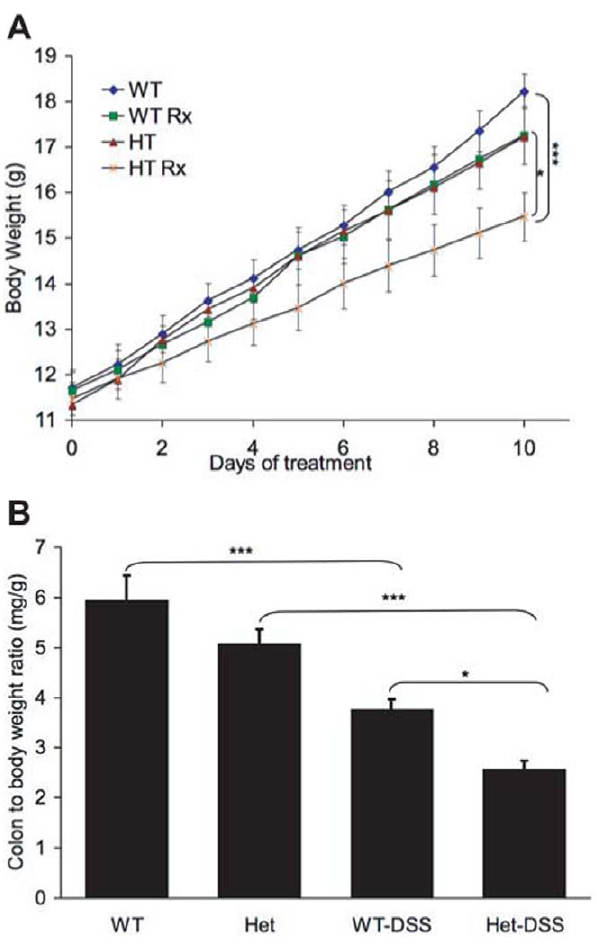
Figure 1. Increased response to DSS treatment in the presence of only one allele of TC-PTP. A . Increased weight loss of TC-PTP + / 2 mice during DSS-induced colitis. At 19 days of age mouse body weight was 11–12 g followed by DSS treatment. Body weight of DSS-treated TC-PTP + / 2 (Het-DSS) (2.58 6 0.4) mice were significantly lower than, TC-PTP + / 2 (Het) (5.0 6 0.8) and TC-PTP + / + (WT-DSS) (3.78 6 0.5) mice *** p , 0.0002. DSS-treated TC-PTP + / 2 mice compared to DSS-treated TC-PTP + / + mice * p , 0.001. Data represent the mean of three groups of three animals each (N=9). B. Ratio of colon weight of DSS-treated TC-PTP + / 2 (Het-DSS) mice were significantly lower than DSS-treated TC-PTP + / + (WT-DSS) mice p , 0.05. In the case of TC-PTP + / 2 (Het) vs. DSS- treated TC-PTP + / 2 (WT-DSS) mice p , 0.001, and p , 0.001 in comparison of TC-PTP + / + vs. DSS-treated TC-PTP + / +